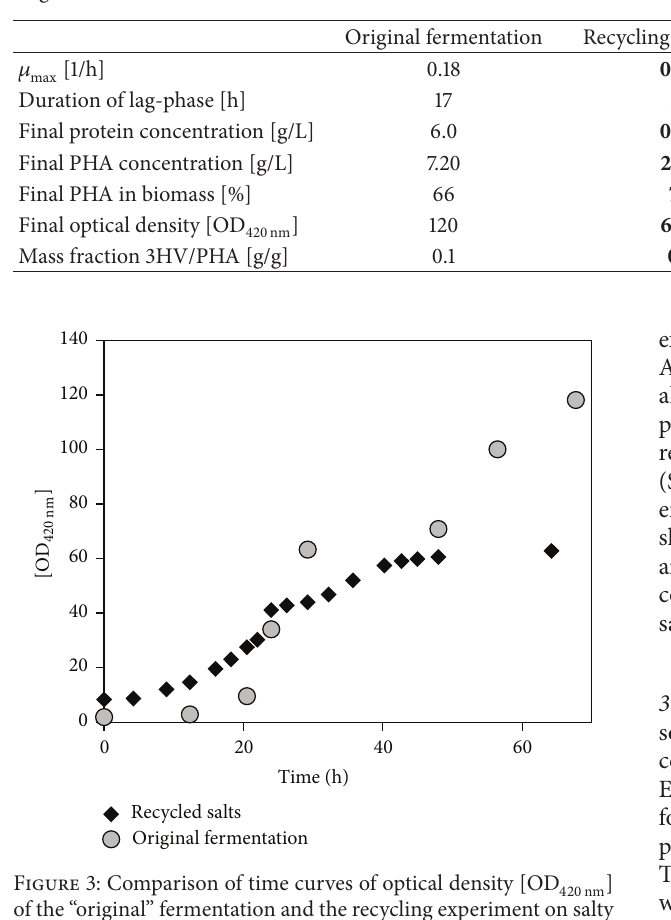
Table 1: Comparison of important results from H. mediterranei DSM 1411 fermentation on recycled salty supernatant (10L scale) and the original cultivation on 300 L scale.